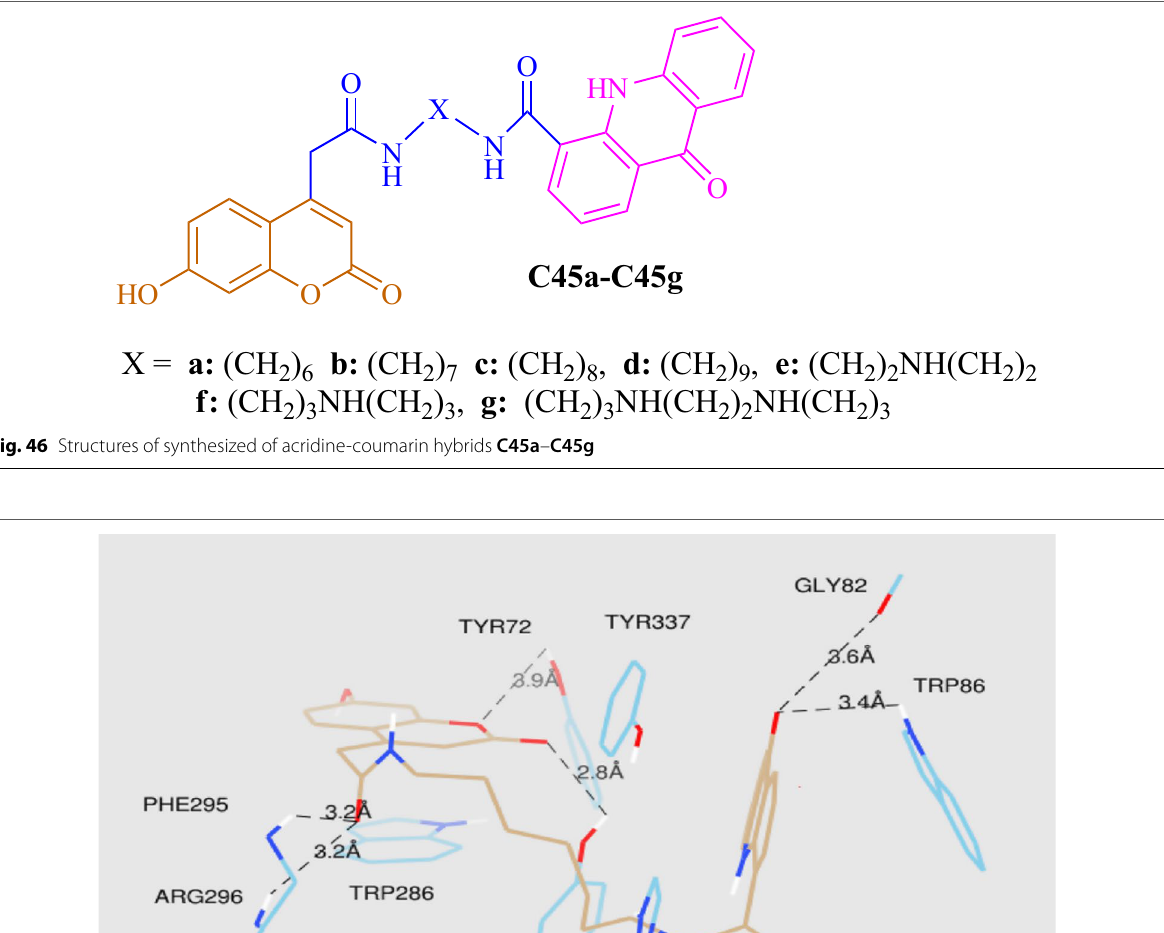
erythrocytes and butyrylcholinesterase inhibitory activity against human plasmatic butyrylcholinesterase against tacrine and the reference drug 7-MEOTA. Among all the